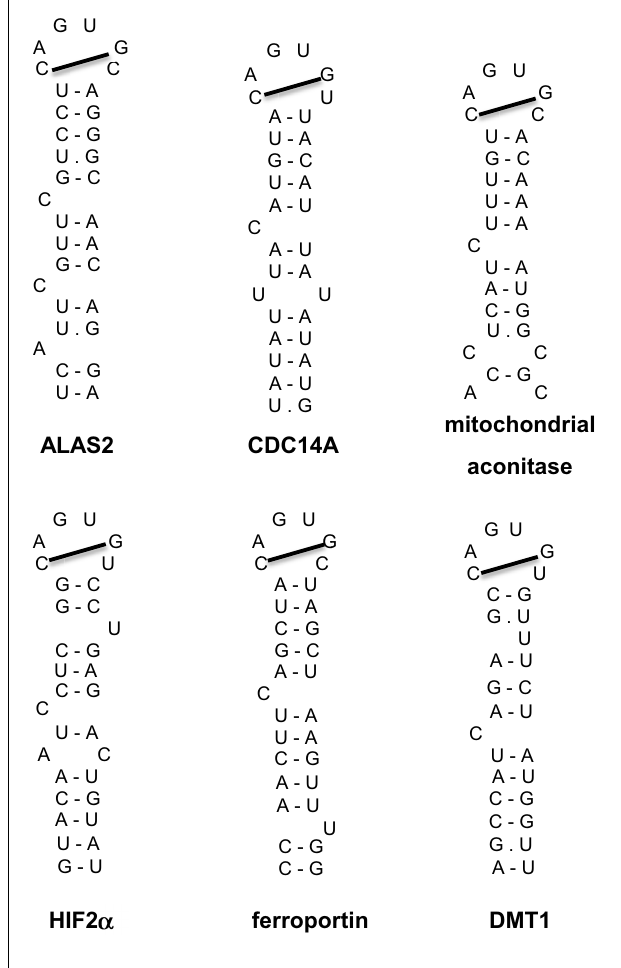
FIGURE 5 | IRE motifs in the untranslated regions of the mRNAs encoding human ALAS2, CDC14A, mitochondrial aconitase, HIF2 α , ferroportin, and DMT1. Watson-Crick base pairing is depicted by a dash and non-Watson-Crick interactions by a dot. The line connecting the 1st and 5th nucleotide of the IRE loop indicates Watson-Crick base pairing.